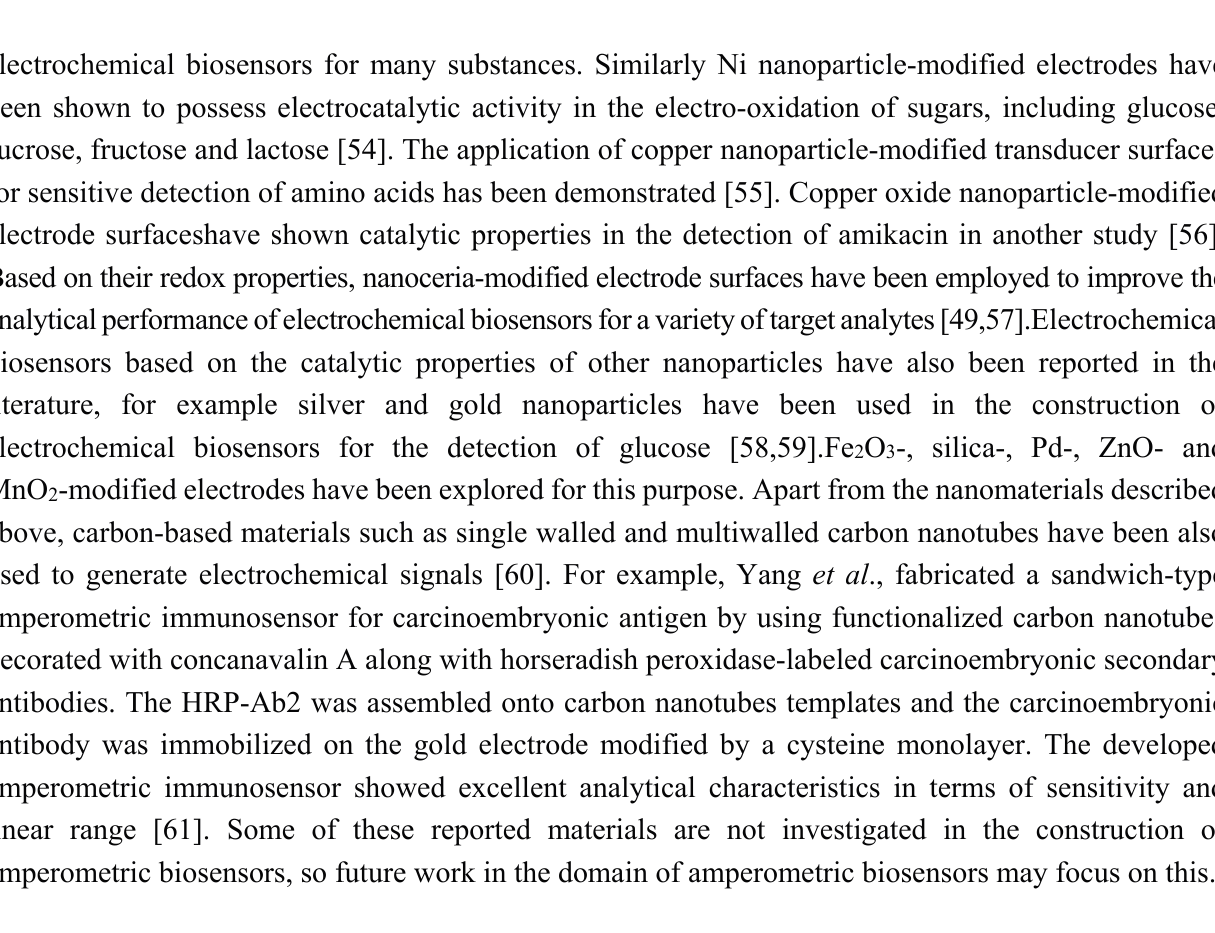
Figure 3. Nanomaterial-based signal amplification through ( A ) catalytic properties; ( B ) mediator; ( C ) deposition of electrochemically active